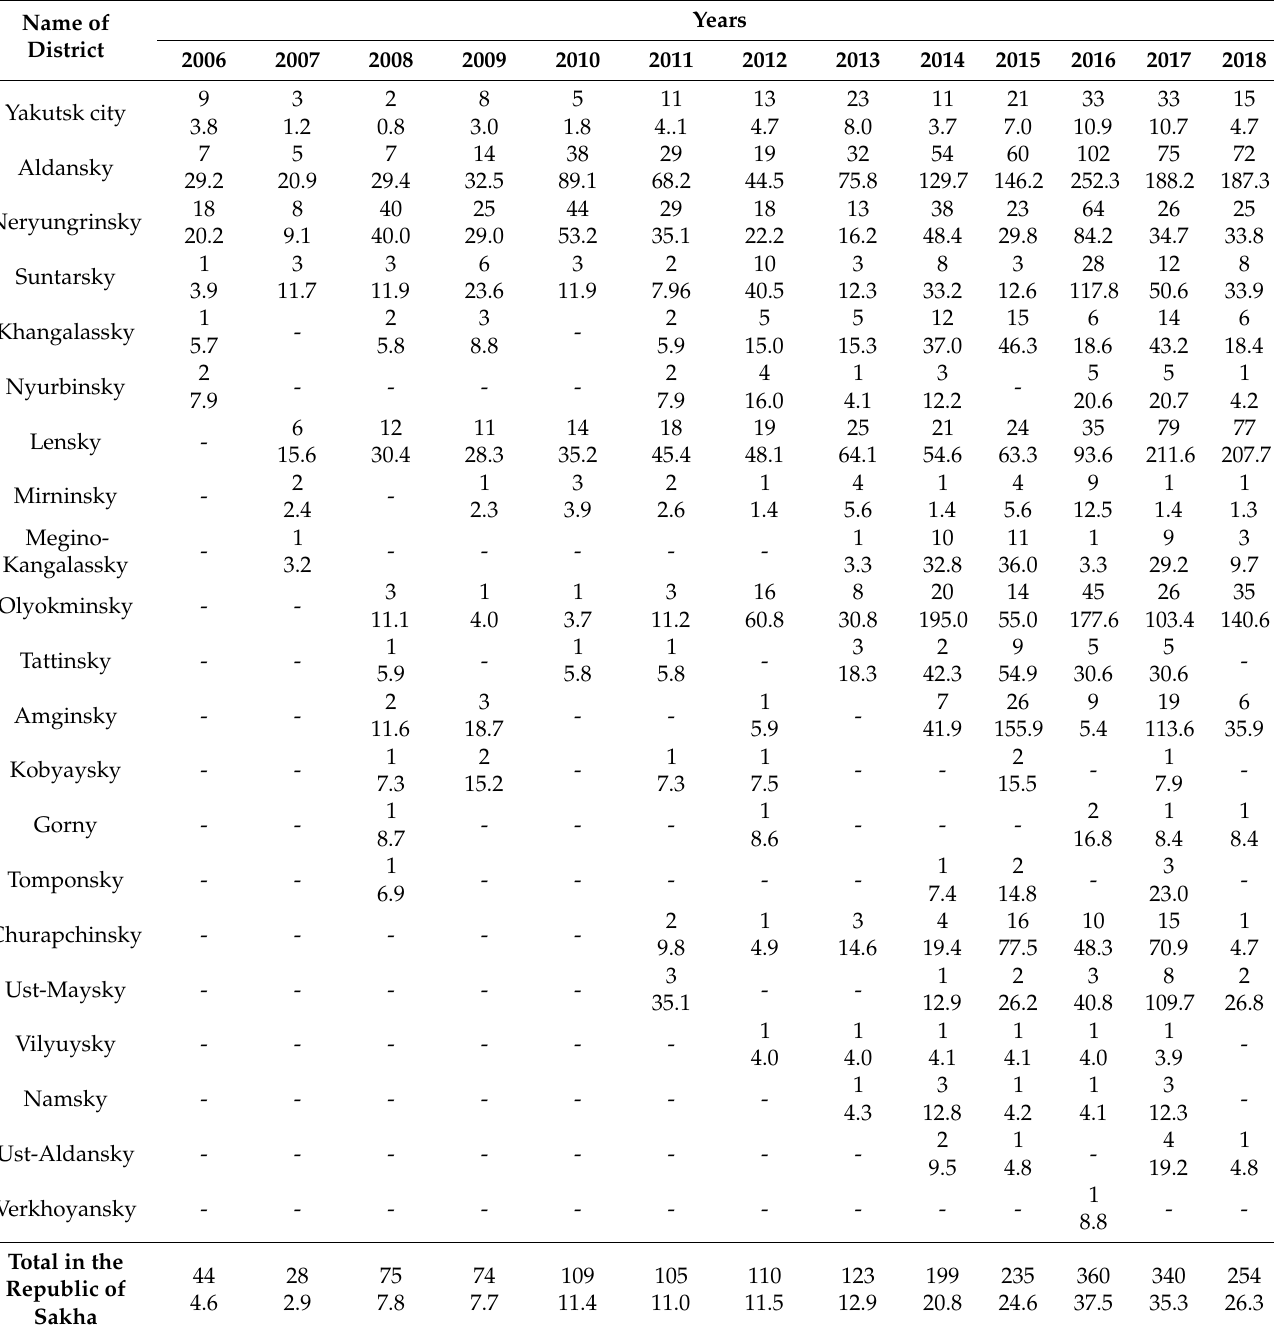
Table 1. Regions of the Republic of Sakha (Yakutia), where tick bites were registered for the period between 2006 and 2018. In each cell, the number of cases are reported, with cases per 100,000 shown below it (according to Rospotrebnadzor of the Republic of